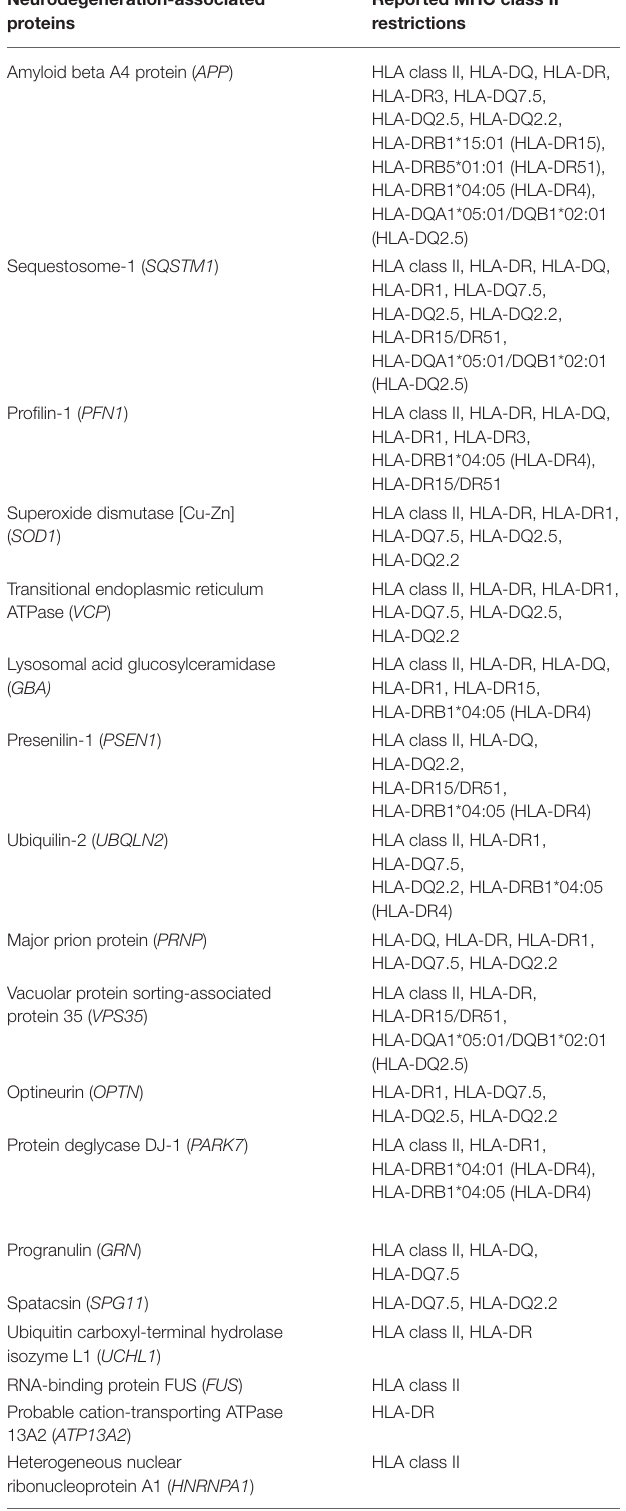
TABLE 4 | List of neurodegeneration-associated proteins from which derive MHC class II-binding endogenous peptides in the human B-cell lineage. Neurodegeneration-associated